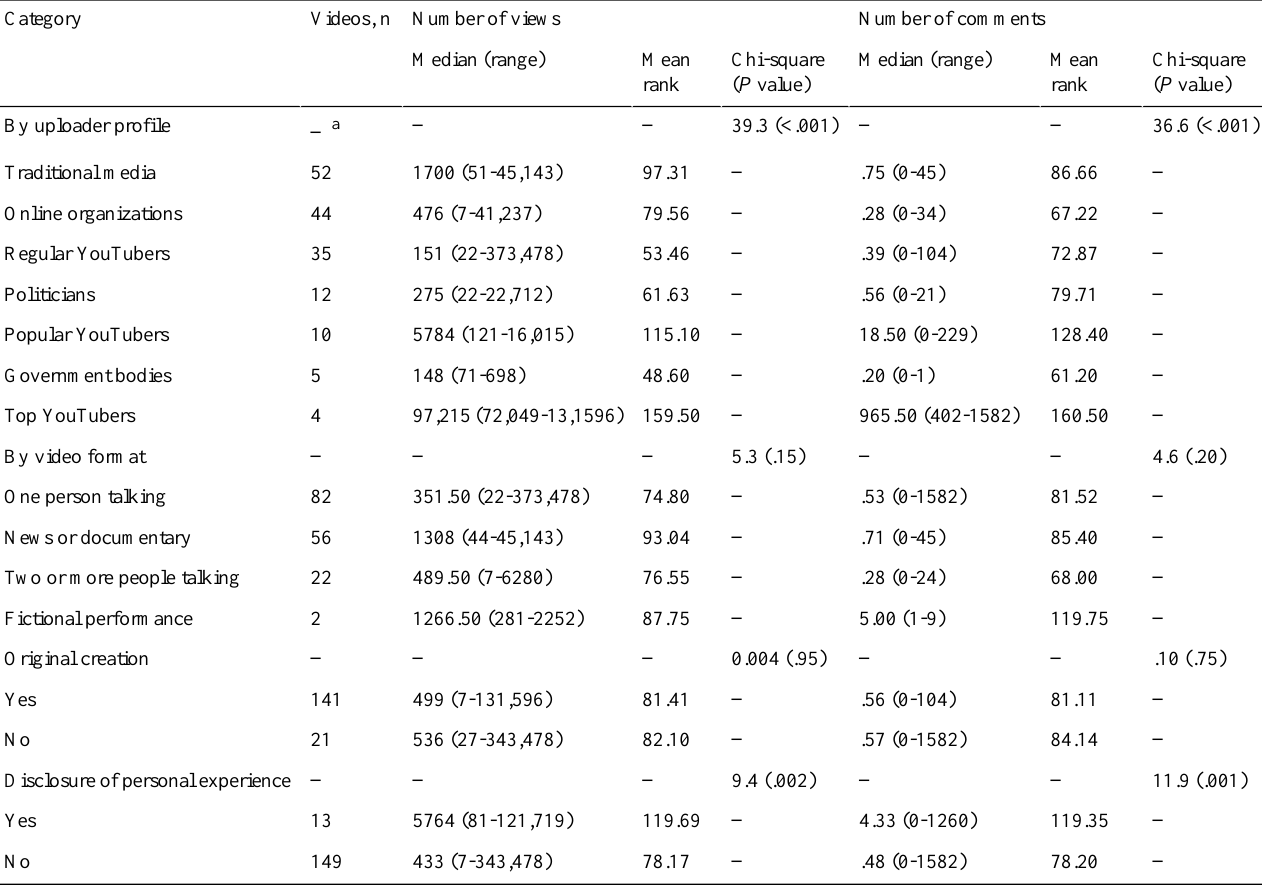
Table 1. Categories of YouTube videos responding to the student suicide issue and a comparison on their reach and engagement (n=162).